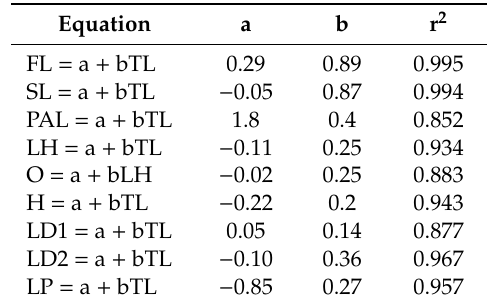
Table 2. Length–length regression parameters (a,b) and determination coe ffi cient (r 2 ) of blue jack mackerel Trachurus picturatus (N = 155) collected during the MEDITS survey in July 2018, eastern Adriatic